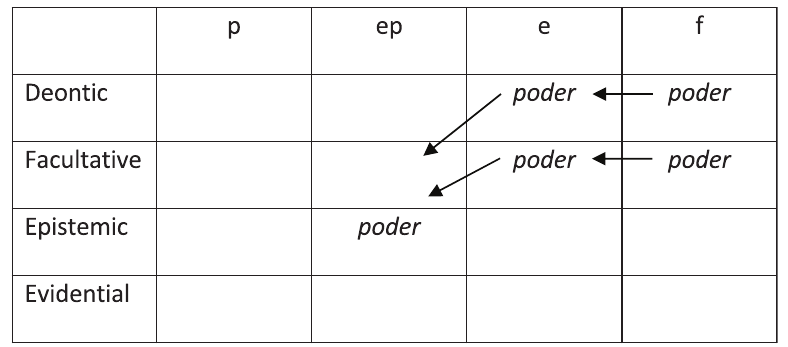
Figure 3: Hypothesized development of poder.